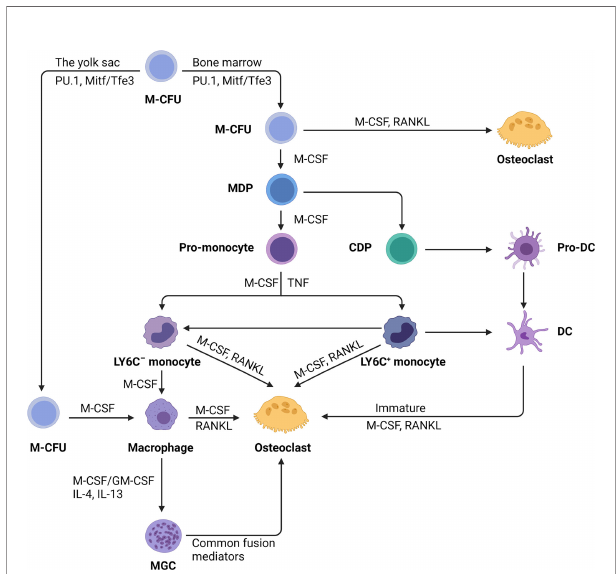
FIGURE 1 | The monocyte/macrophage origin of osteoclasts. Hematopoietic stem cells myeloid colony-forming units (M-CFU) from bone marrow or yolk sac is the main site of myeloid cell production. Recent researches have shown that tissue-resident macrophages initially arise from myeloid stem cells (M-CFU) in the yolk sac of the developing embryo. In M-CFU, early expression of PU.1 and Mitf induces the emergence of M-CSFR (the receptor for M-CSF). Subsequently, in combination with macrophage colony ‐ stimulating factor (M-CSF) and receptor activator of NF ‐ k B ligand (RANKL), M-CFU can differentiate directly into osteoclasts. But in the separate action of M-CSF, M-CFU can differentiate into M-CSF-dependent macrophage and dendritic cell progenitor (MDP). MDP can differentiate into both dendritic cells and monocytes, the latter of which can differentiate into pro-monocytes under the sustained action of M-CSF. Pro-monocytes can differentiate to form speci fi cally marked monocytes, namely: LY6C + or LY6C - blood monocytes, under appropriate stimulation, such as M-CSF, TNF. Monocytes (Ly-6C − ) induced by M-CSF develop into macrophages, but the addition of RANKL converts monocytes into osteoblasts commitment. Early-stage Ly-6C + monocytes exhibit a high potential for osteoclast commitment in response to M-CSF and RANKL activation while still retaining the capacity to transform into Ly6C - monocytes. Completely differentiated macrophages induced by M- CSF and RANKL can fuse to become osteoclasts. Under pathological situations, macrophages can generate multinucleated giant cells (MGCs) when stimulated with M-CSF or stimulating factor (GM-CSF) and interleukins (IL-4, IL-13). MGCs continue to differentiate into osteoblasts in the presence of common fusion mediators. In addition, immature dendritic cells have the potential for osteolytic